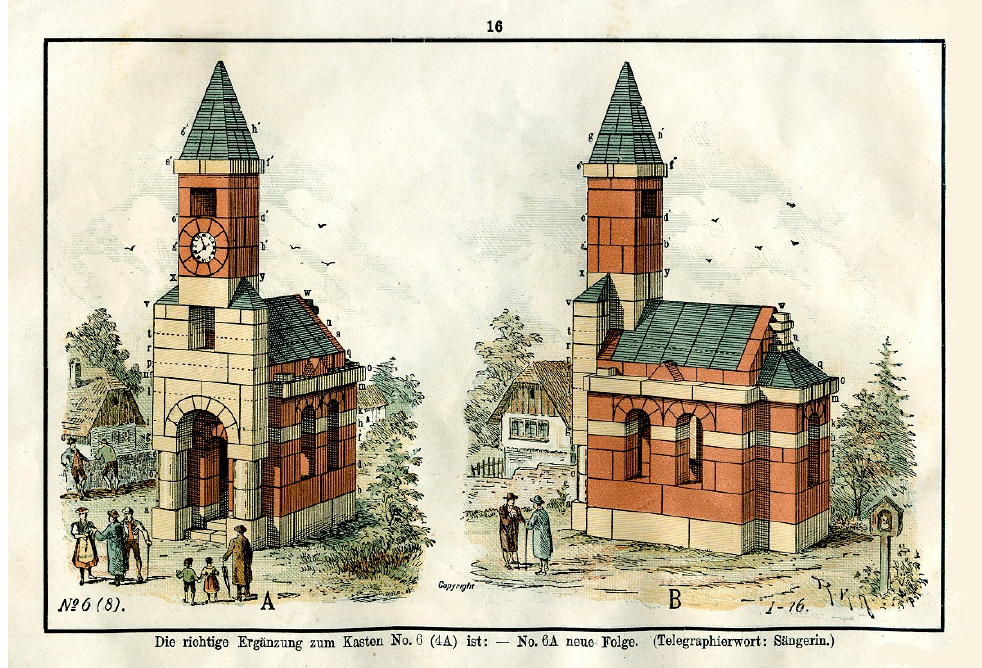
Figure 4. Assembly instructions for Anker Steinkasten kit 6A, late 19th-century.